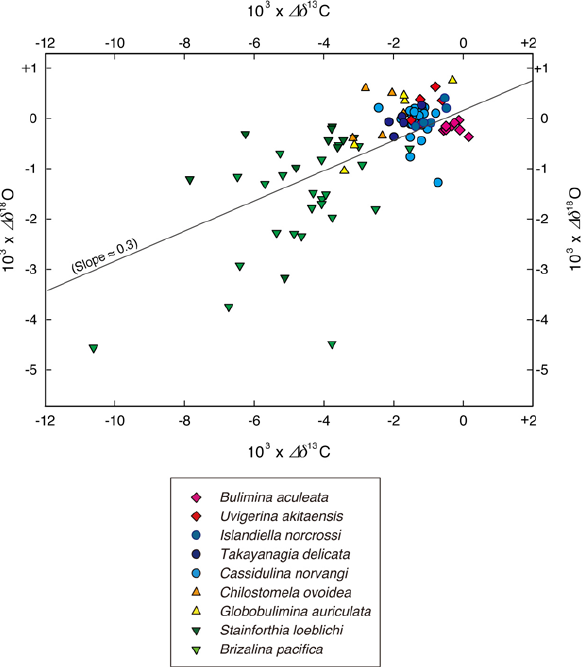
Fig. 7. Relationship between 1δ 13 C and 1δ 18 O of individual ben- thic foraminifera. Solid line indicates the reported trend of the iso- topic shift caused by the carbonate ion concentration effect (Spero et al.,